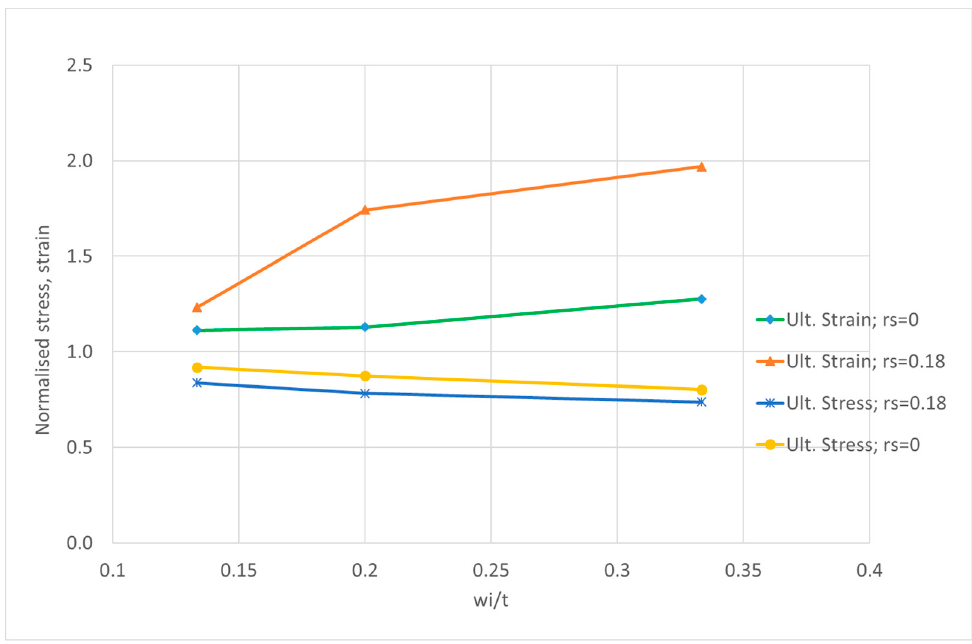
Figure 9. Variation of ultimate strength and corresponding normalized strain for plates with t = 15 mm, m = 3 and no residual stresses.